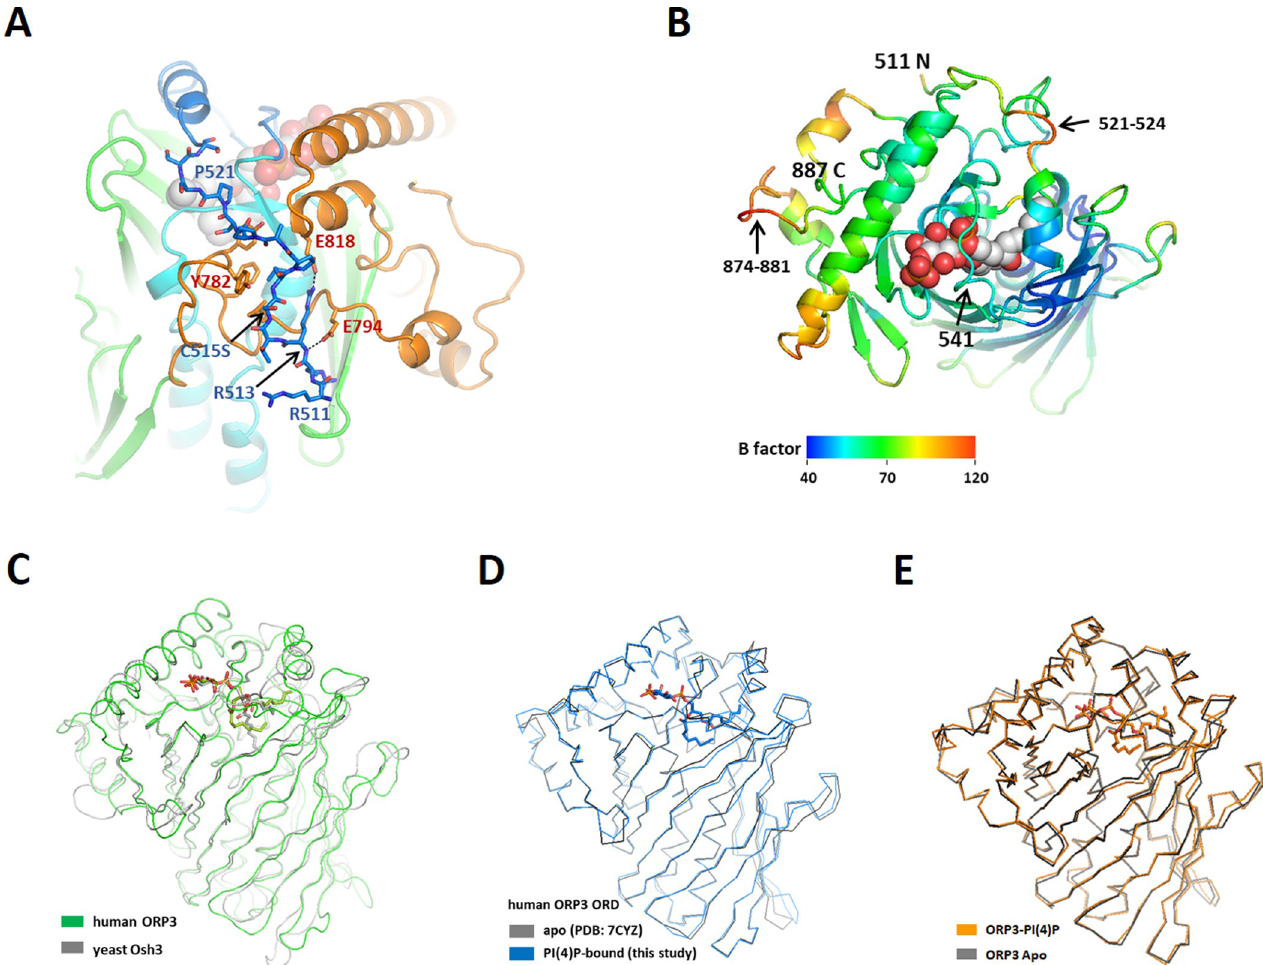
Fig 2. Structure comparison of ORDs. (A) The N-terminal upstream residues of the lid. The residues 511–524 are shown in stick models. (B) B-factor representation of the ORP3 ORD. Top view of Fig 2A. (C) Structure superposition of the ORD domains from human ORP3 and yeast Osh3. The PI(4)P of ORP3 is shown in cyan and the PI(4)P of yeast Osh3 in gray. (D) Structure comparison of apo and PI(4)P-bound ORP3 ORDs. (E) Structure comparison of the PI(4)P-bound ORP3 ORD (this study) and the apo ORP3 ORD (PDB id: